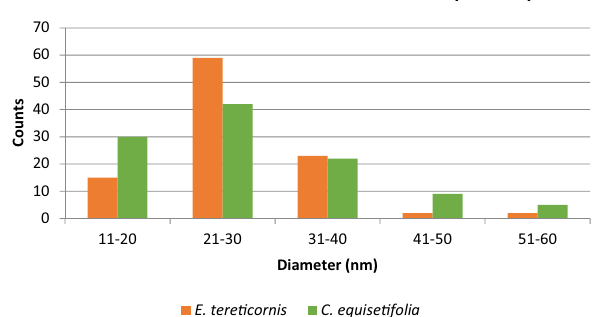
Figure 4. Diameter distribution of nanofibres extracted from eucalyptus and casuarina.